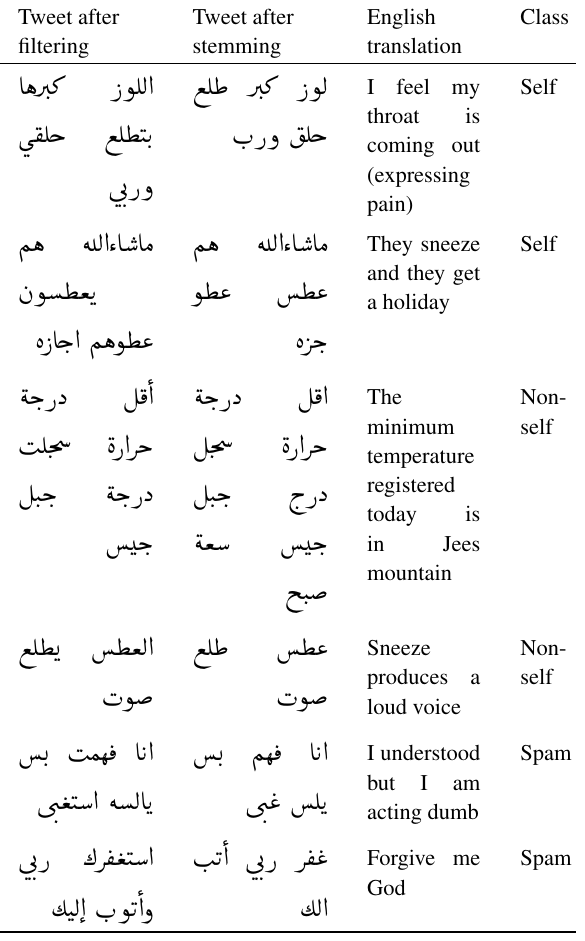
Table 6 English words with multiple meaning based on contexts. Table 4 Examples of Influenza related keywords. Keyword English Flu, Influenza, cold, sneeze, fever, sore, dry, throat, fatigue, virus, germs, runny nose, respiration, mucus, sinusitis